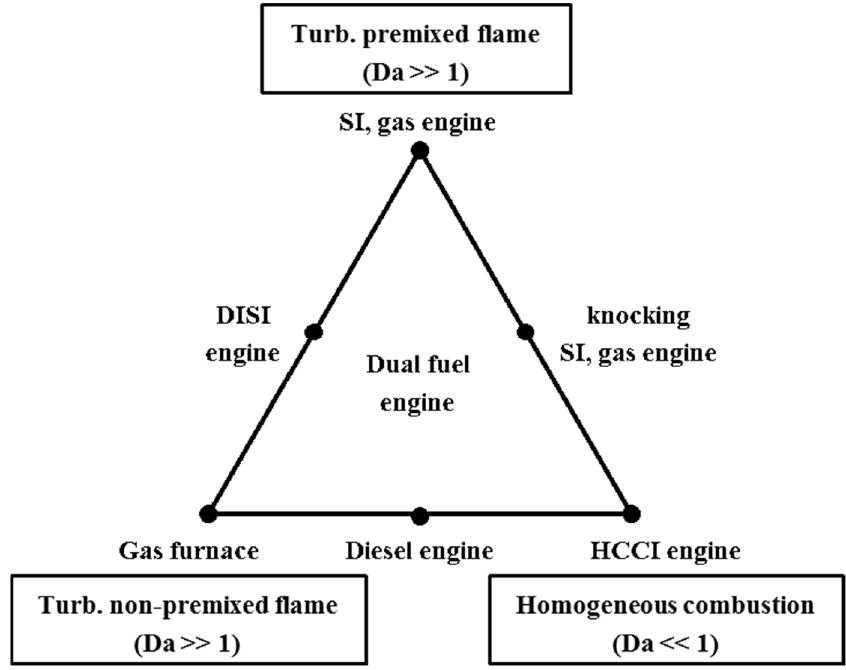
Figure 4. Flame types in combustion engines (based on [49]).